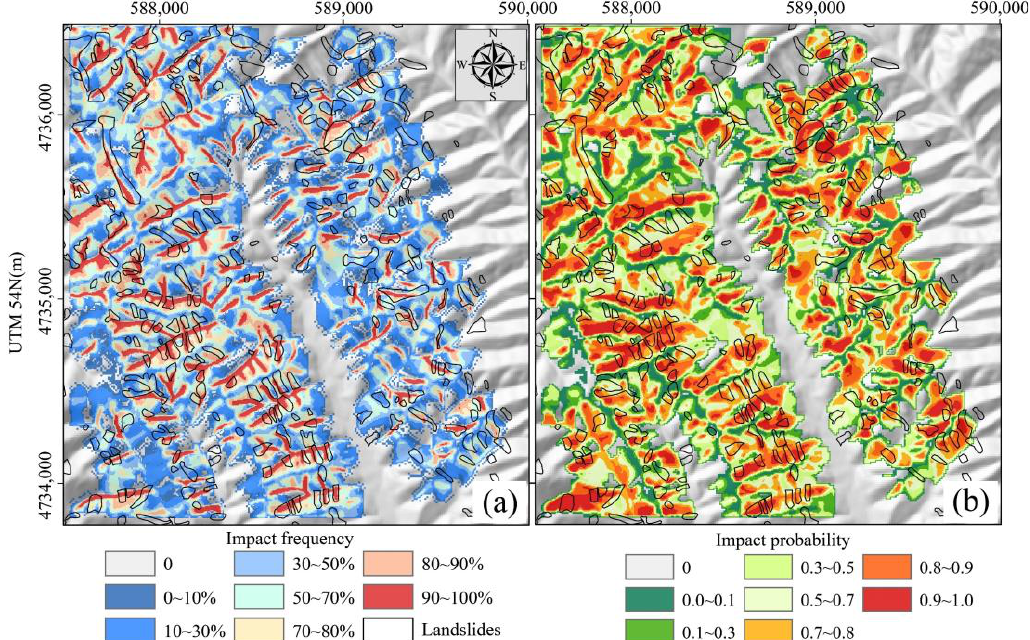
Figure 12. A combination of landslide source area prediction and landslide run-out modelling por- traying the respective distribution of ( a ) the landslide impact frequency (expressed as the cumulative distribution function) and ( b ) the landslide impact probability. The landslide run-out model uses r.randomwalk [59], in which the motion is controlled by the landslide angle of reach. The average angle of reach (25°) and the probability distribution function used for modeling were calculated during the statistical analysis of the landslides.